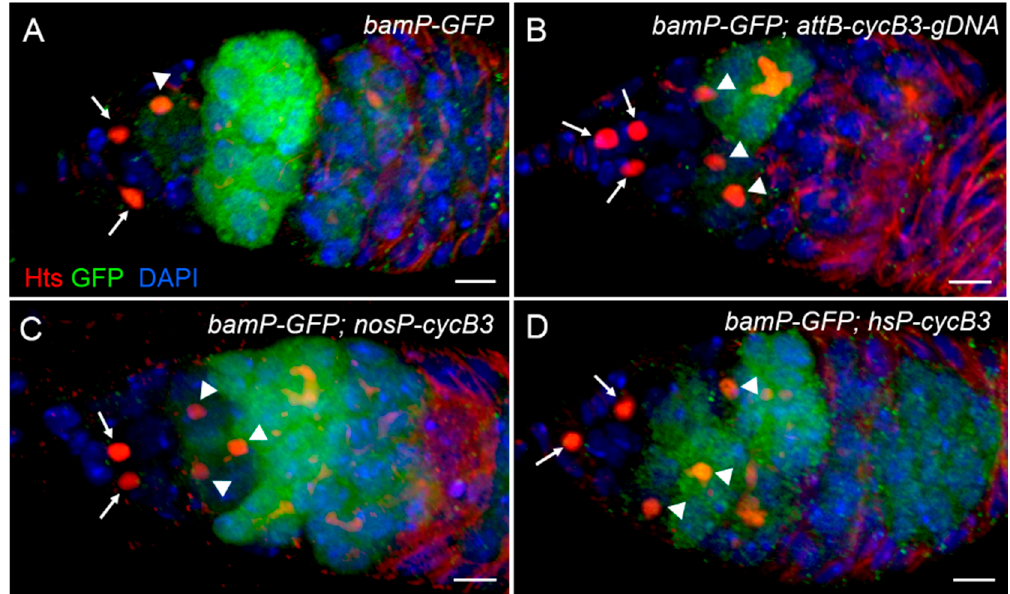
Figure 7. Over-expression of cycB3 notably increases the number of CBs. Ovaries from wild-type ( A ) and cycB3 -overexpression flies ( B – D ) were stained with anti-Hts antibody (red), anti-Vasa antibody (green), and DAPI dye (blue). The micrographs were stacked together in the Z-axis direction, to visualize spectrosome-containing GSCs (indicated by arrows) and CBs (noted by arrowheads). Scale bars: 5 μ m.